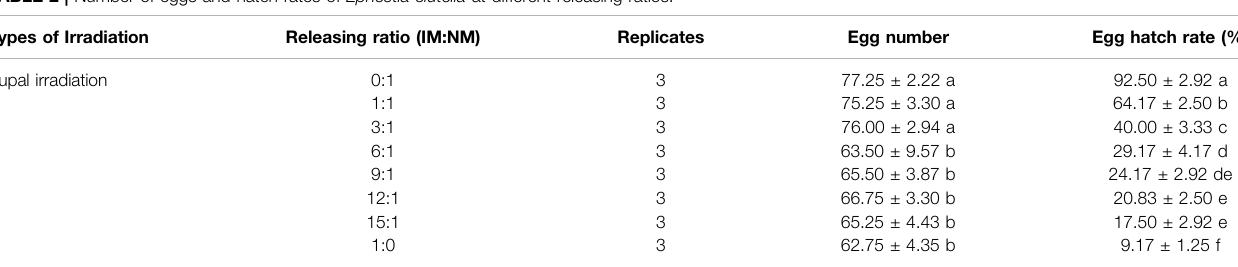
Different letters indicate signi fi cant differences among treatments (ANOVA and Tukey ’ s HSD test, p < 0.05).